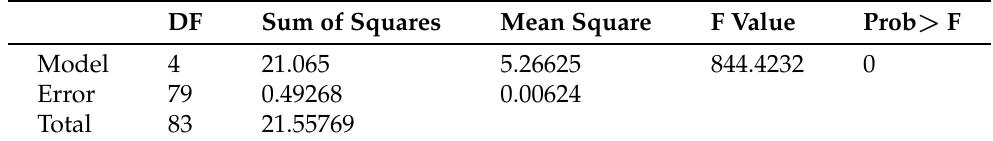
Table 5. Calculated results of ANOVA .